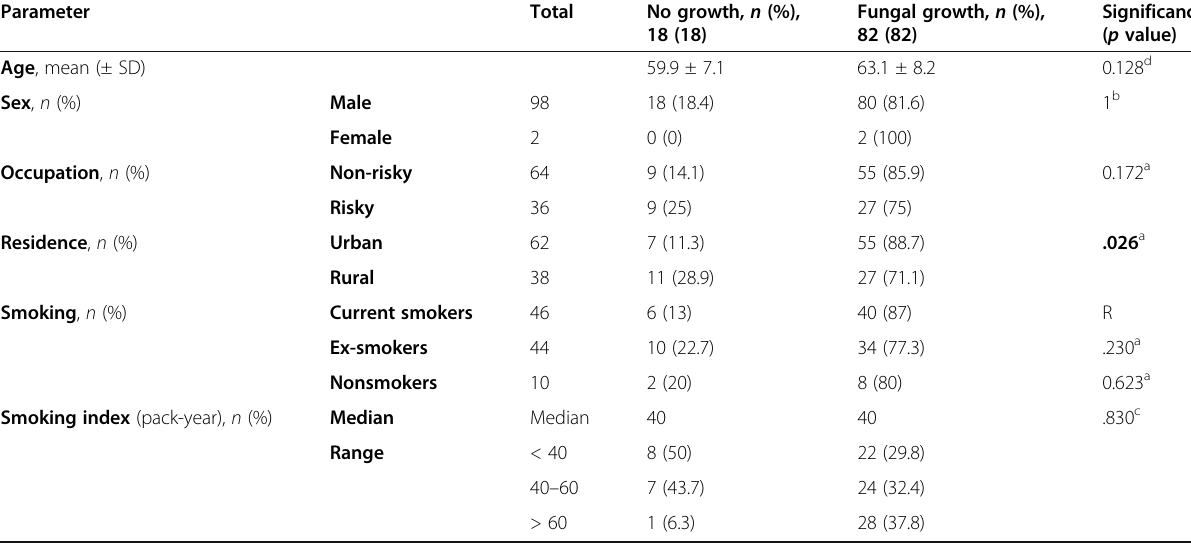
Table 7 Fungal isolates in association to sociodemographic characteristics of studied patients Parameter Total No growth, n (%),